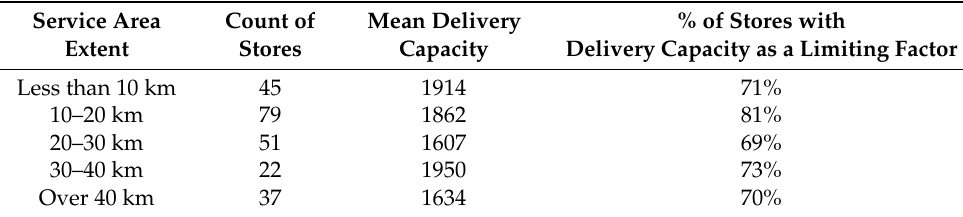
Table 6. Delivery capacity and limiting factors by inferred service area